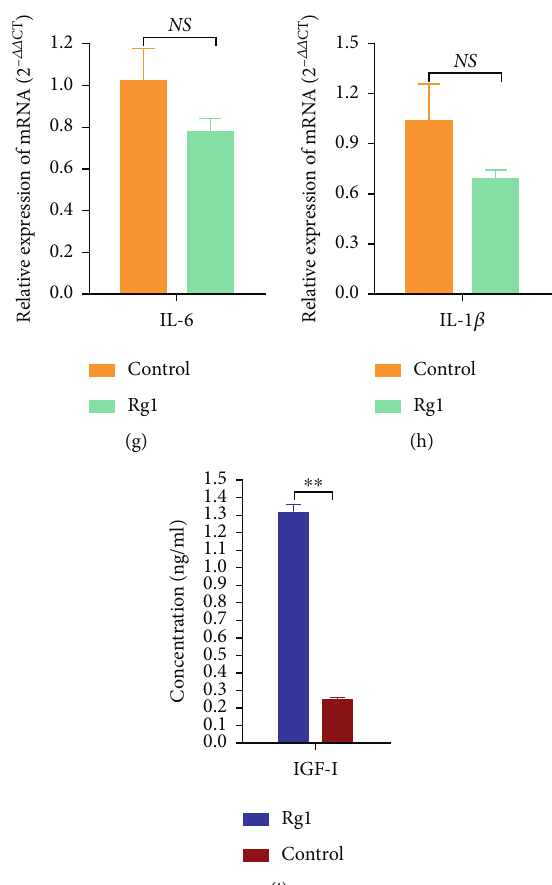
Figure 8: E ff ects of ginsenoside Rg1 on the paracrine of hAD-MSCs. (a – h) The relative mRNA expression levels of HGF (a), FGF2 (b), G- CSF (c), VEGF (d), IGF-I (e), IL-10 (f), IL-6 (g), and IL-1 β (h) in hAD-MSCs in the control and Rg1 groups were detected and compared by RT-qPCR. (i) The levels of IGF-I secreted by hAD-MSCs in the cell supernatant in the control and Rg1 groups were detected by ELISA. NS: not signi fi cant, ∗ P < 0 : 05 and ∗∗ P < 0 : 01